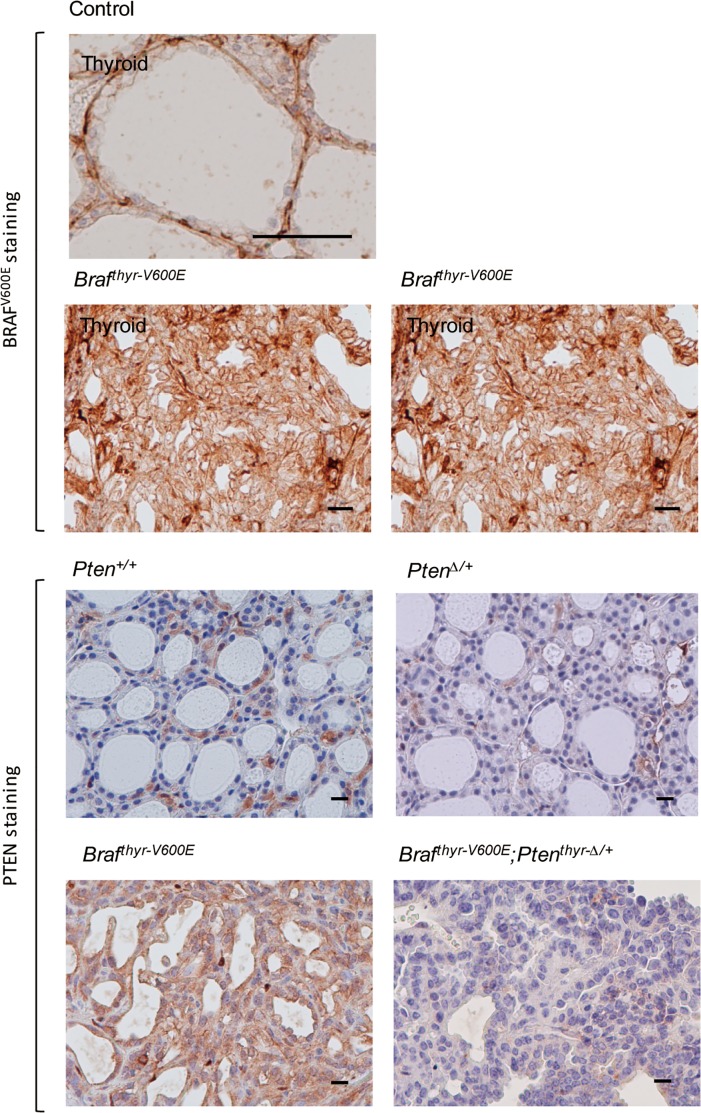
BRAFV600E staining of the thyroid gland and lung tissue in control and Brafthyr-V600E mice, and PTEN staining of the thyroid gland in Pten+/+, PtenΔ/+, Brafthyr-V600E and Brafthyr-V600E;Ptenthyr-Δ/+ mice.The thyroid gland and lung were removed in the mice from Fig 2, and subjected to BRAFV600E and PTEN staining as described in the Materials and Methods. Scale bars, 50 μm.